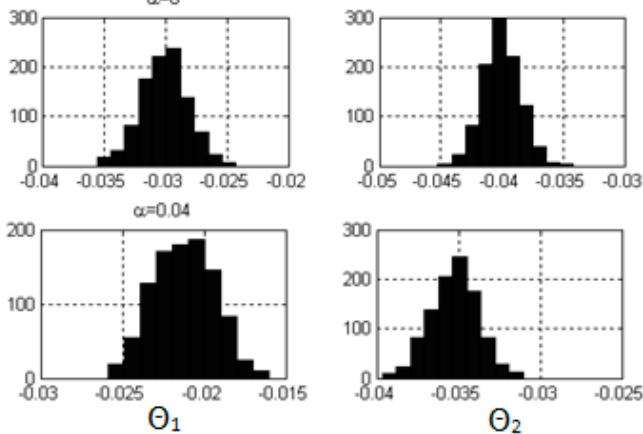
Figure 4. Distributions of estimations when two parameters are estimated.